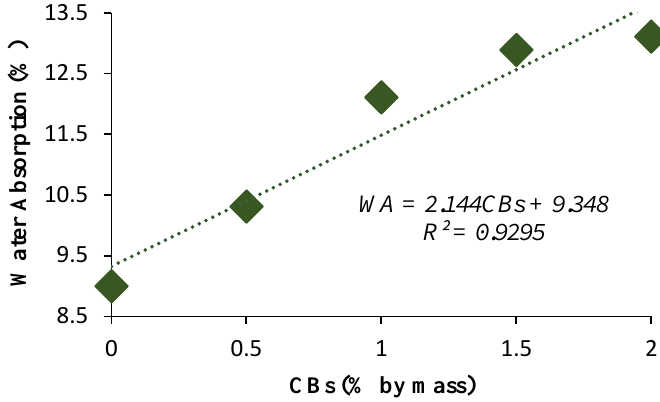
Figure 10. Compressive strength versus CB percentage by mass.